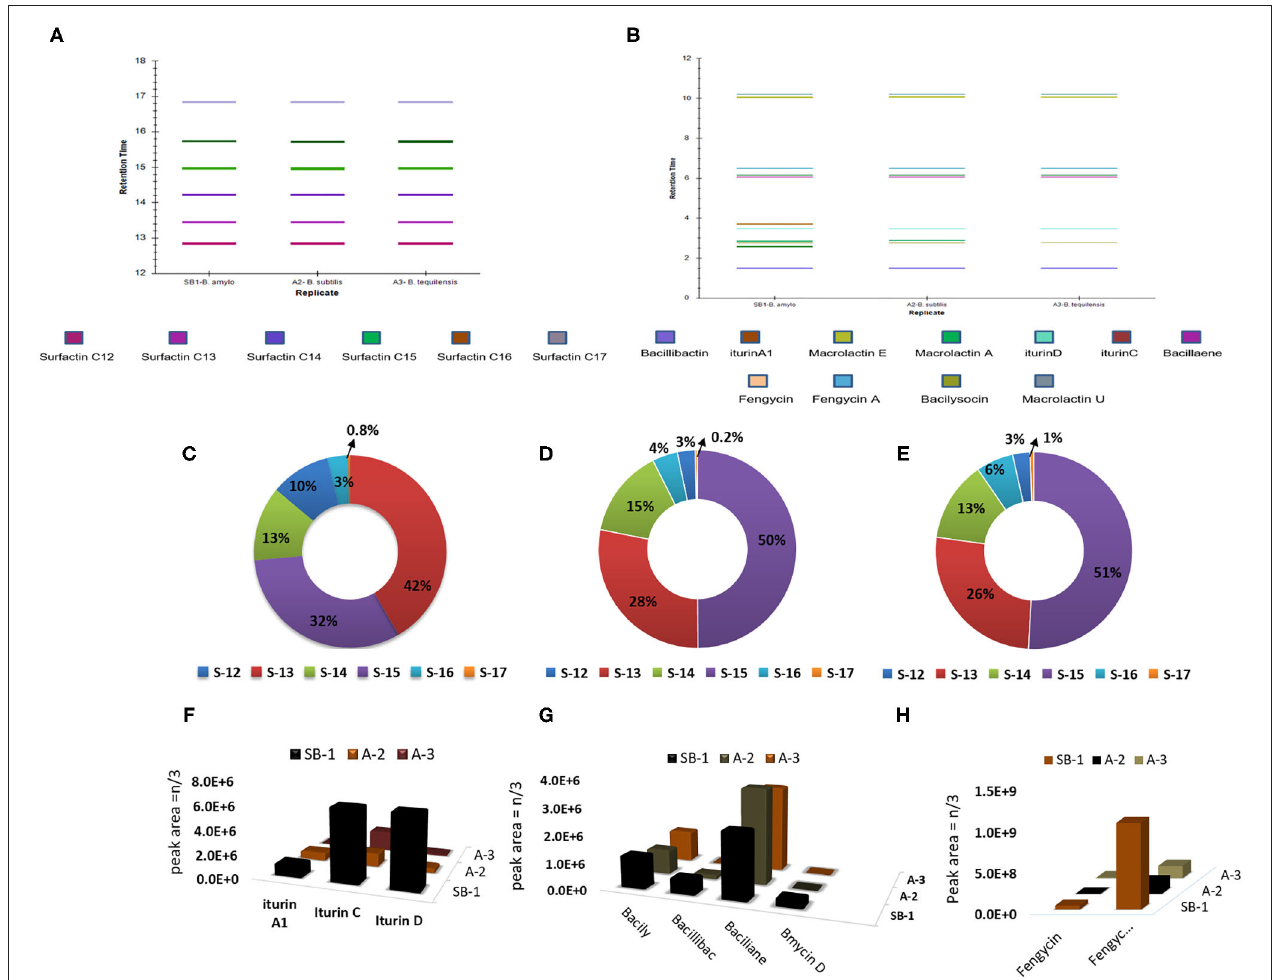
FIGURE 3 | Retention times of bioactive metabolites produced by Bacillus strains SB-1, A2, and A3 (A,B) , percentage of various surfactin homologs in B. amyloliquefaciens SB-1 (C) , B. subtilis A-2, (D) , and B. tequilensis A-3, (E) , and amount of various antimicrobials detected in Bacillus spp. strains (F–H) .